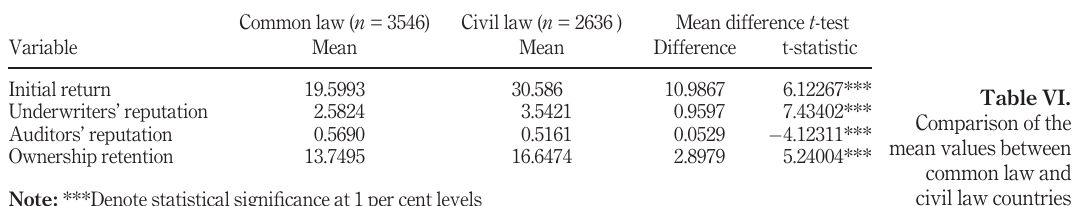
Table VI. Comparison of